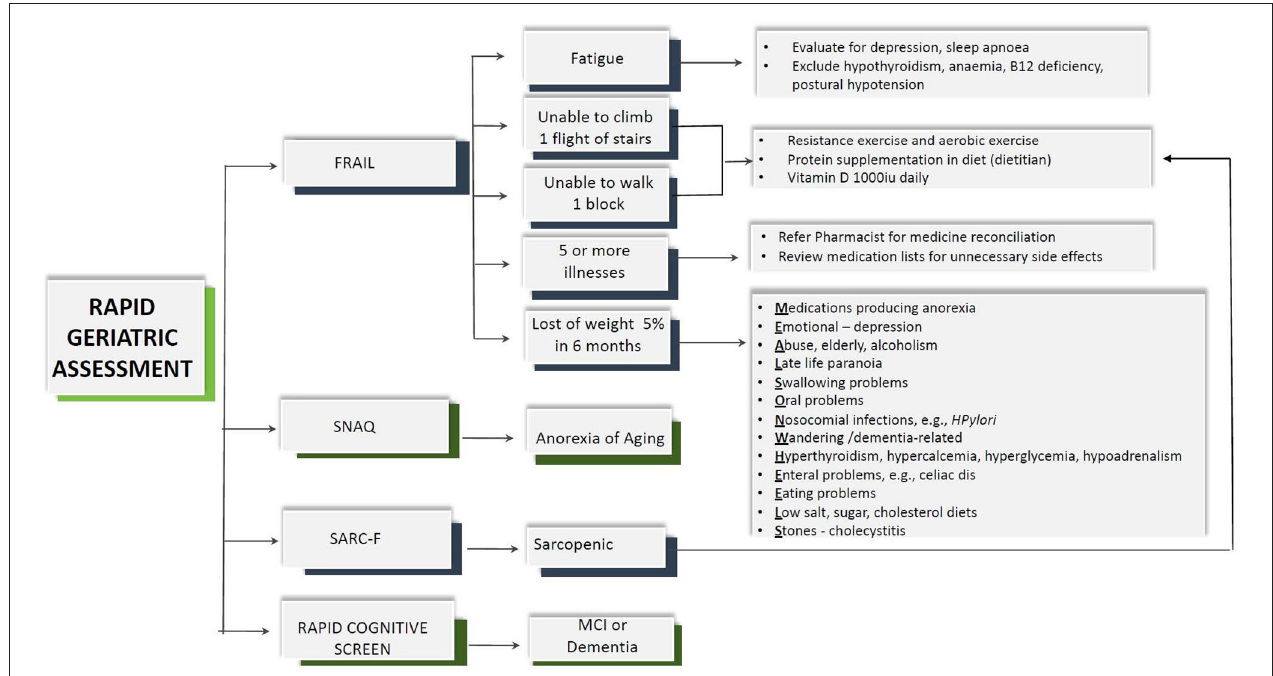
FIGURE 2 | Rapid geriatric assessment and personalized